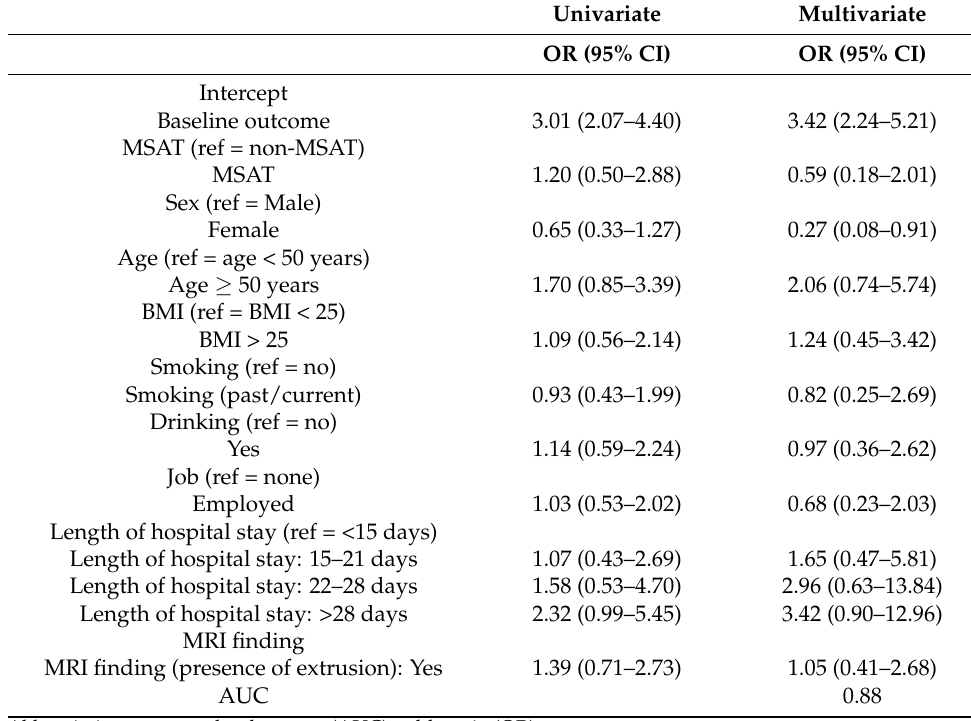
Table 5. Logistics for NRS of